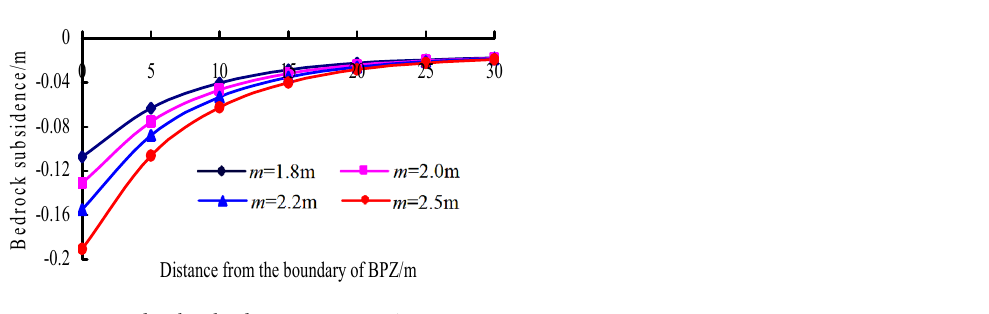
Figure 14. Bedrock subsidence vs. m in